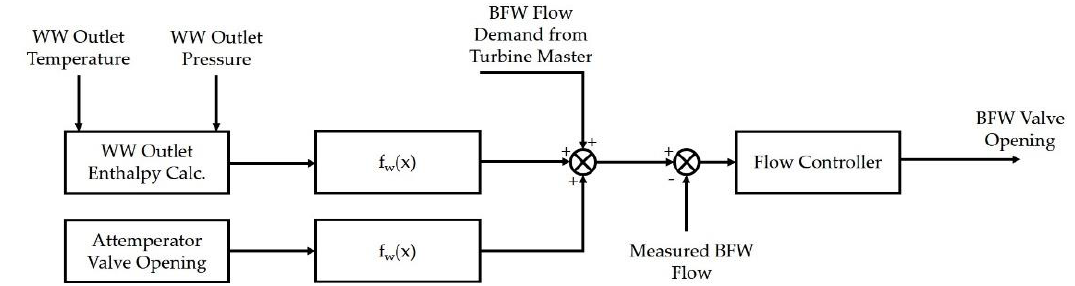
Figure 11. Boiler Feedwater (BFW) Flow Control Scheme.